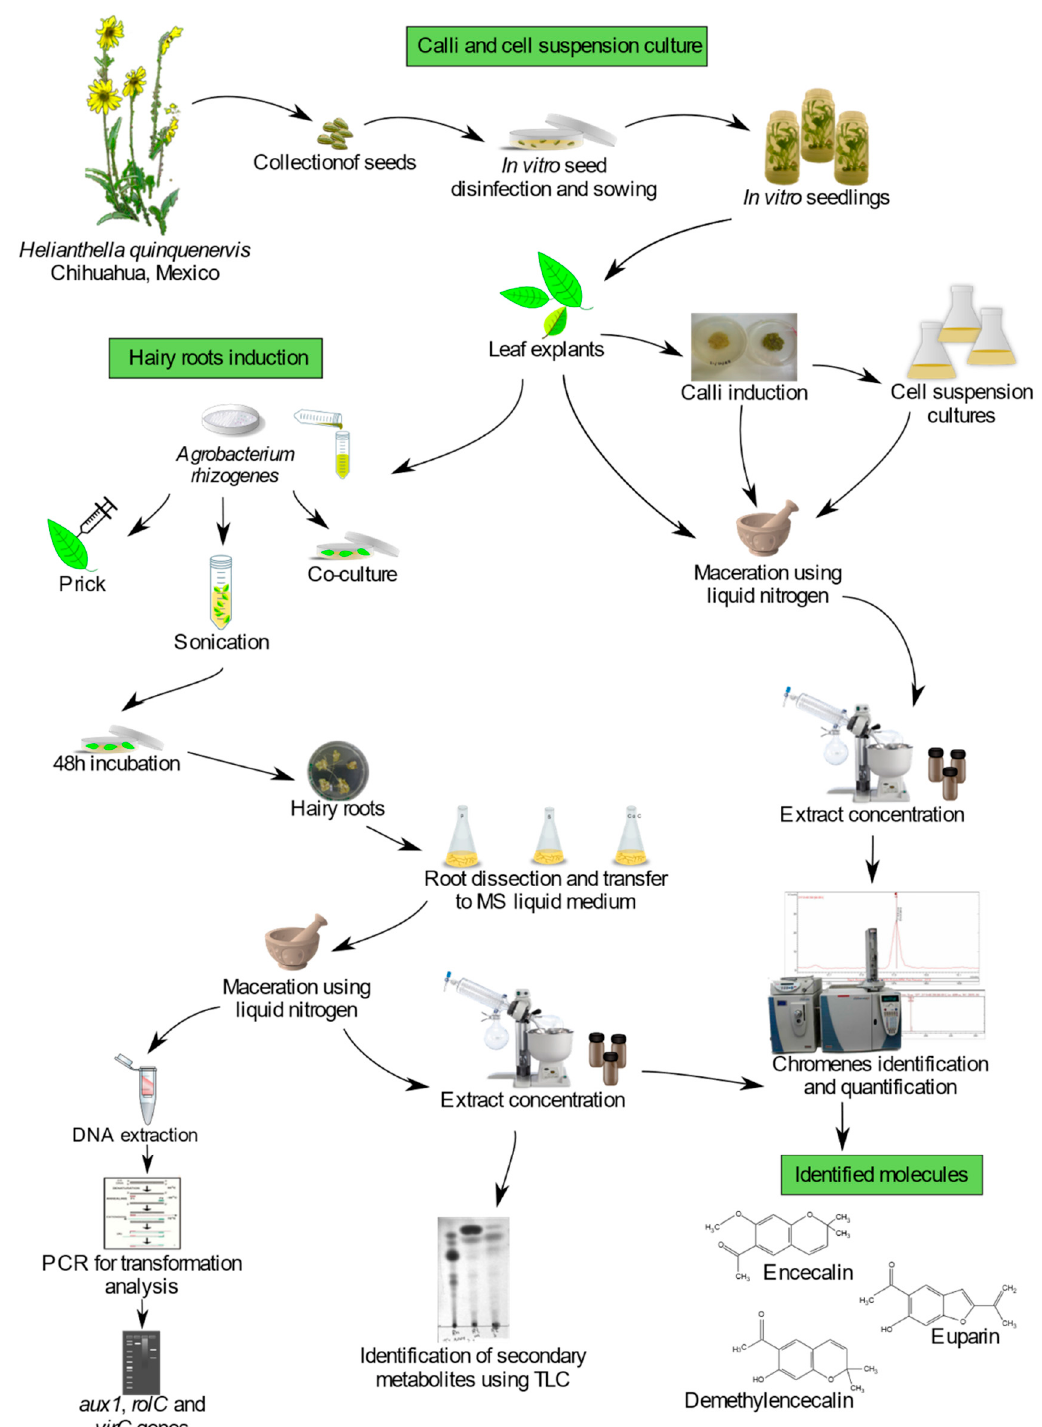
Figure 10. Experimental workflow.